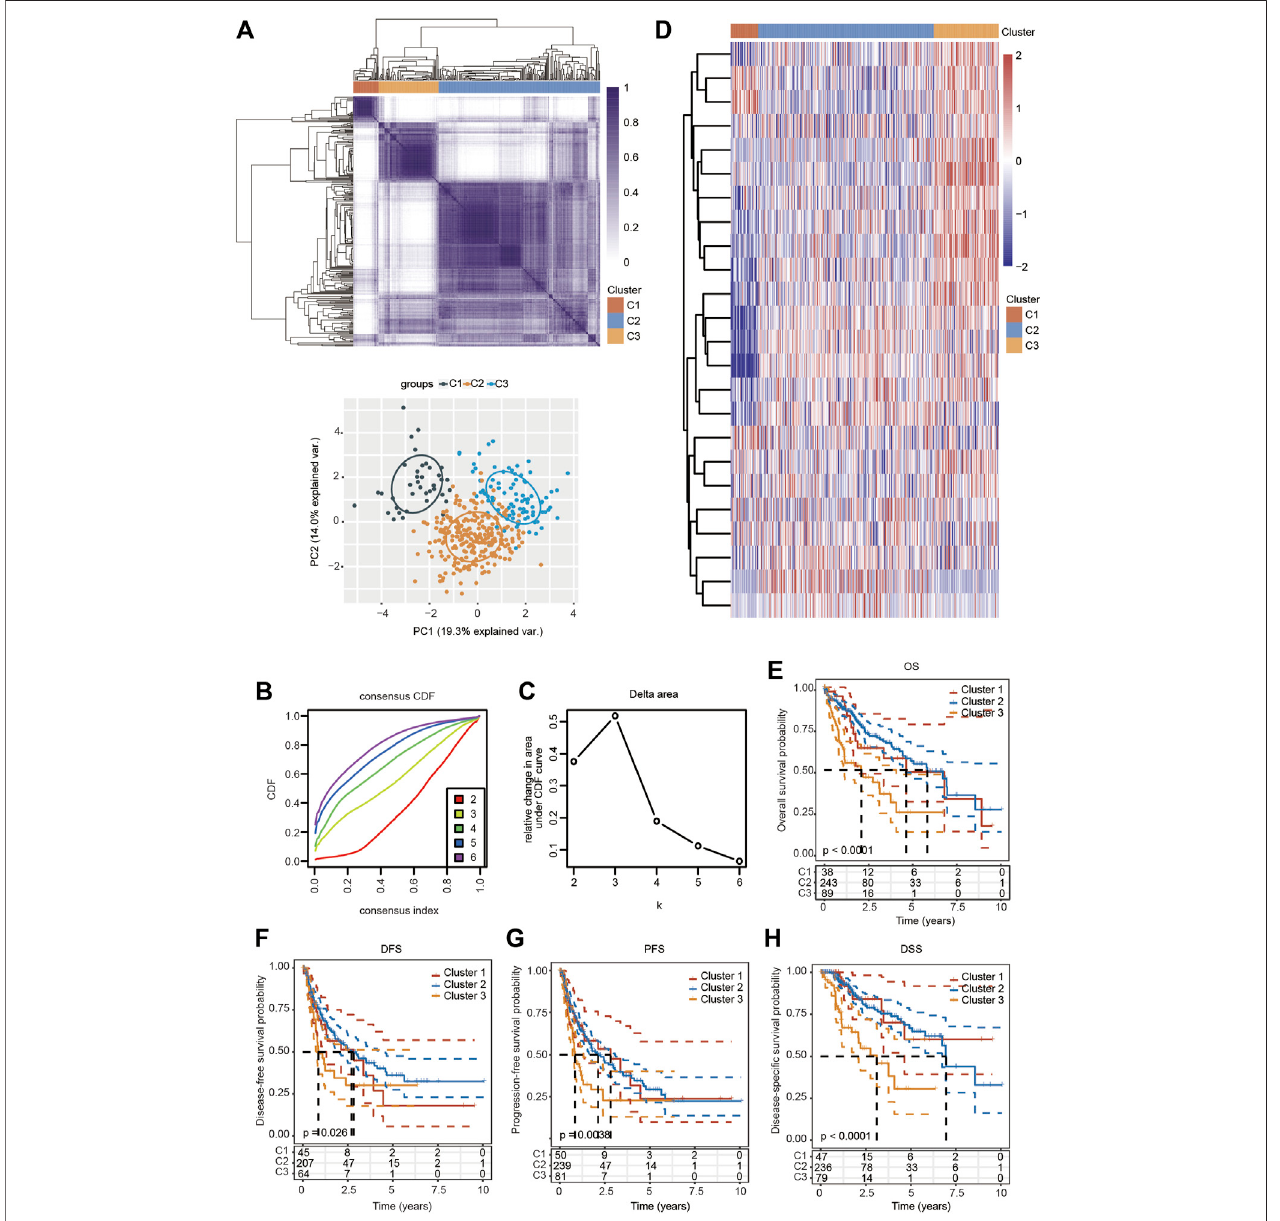
FIGURE 3 | Survival analysis and changed expression of FRGs in distinct HCC clusters in the TCGA cohort. (A) Consensus clustering matrix for k = 3. (B,C) Cumulative distribution function curves for k = 2 – 6. (D) Heatmap visualizing the expression patterns of FRGs in three clusters. (E – H) The Kaplan – Meier curves indicate the OS (E) , DFS (F) , PFS (G) and DSS (H) for three clusters of HCC